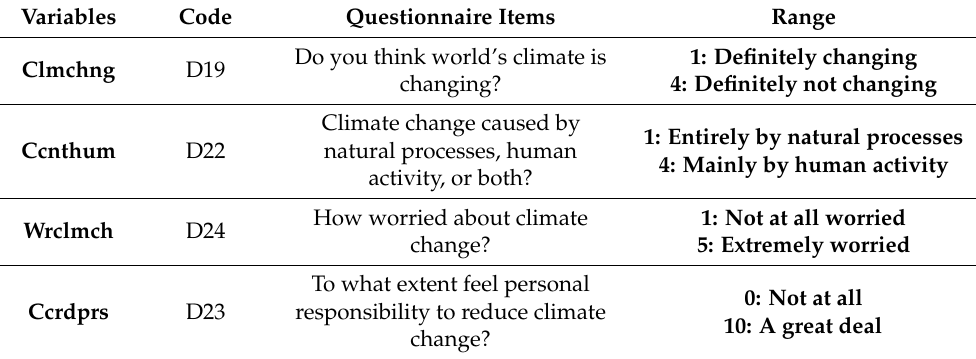
Table 1. Variables in the